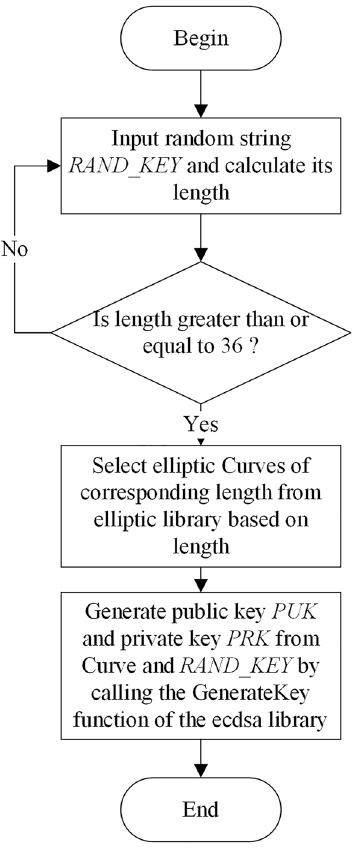
Figure 6. Public and private key pair generation